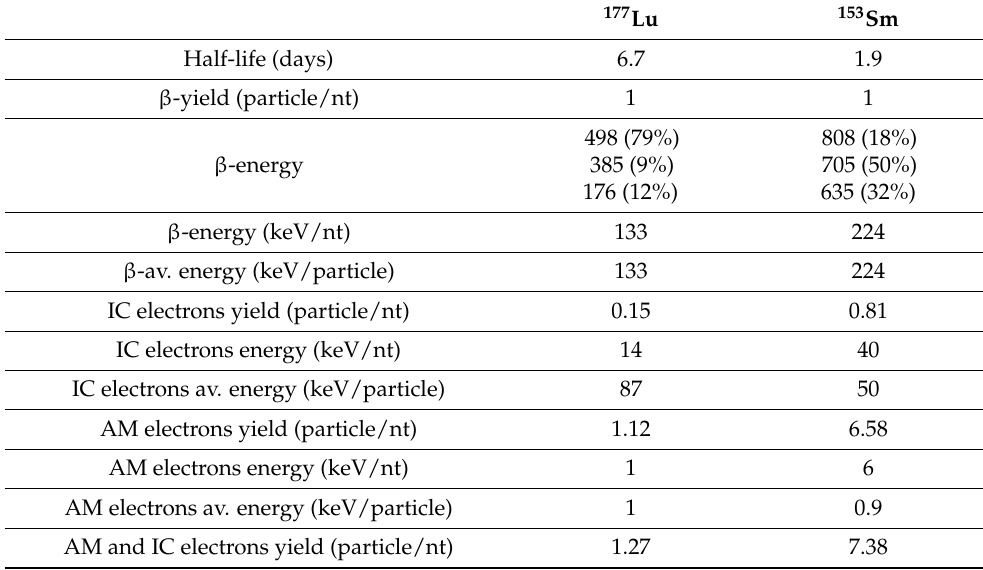
Table adapted with permission from Uusijärvi et al. [1] and IRCP Publication 107—Nuclear Decay Data for Dosimetry Calculations [8]. Nt = nuclear transformation, IC = internal conversion, AM =